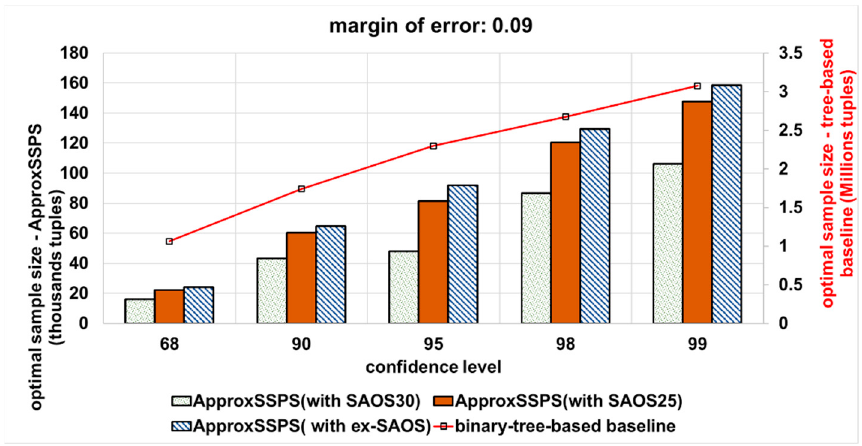
Figure 9. The optimal sample size that is required to achieve a more permissive accuracy target (an error bound that equals 0.09) for both systems (ApproxSSPS and the tree-based baseline): “computing the average ‘speed’ in Shenzhen mobility data”. ApproxSSPS with all geohash precisions and for all confidence levels achieves a significantly much lower optimal sample size as opposed to the baseline. It is a discernible pattern that all methods require a higher sample size as the confidence level increases.